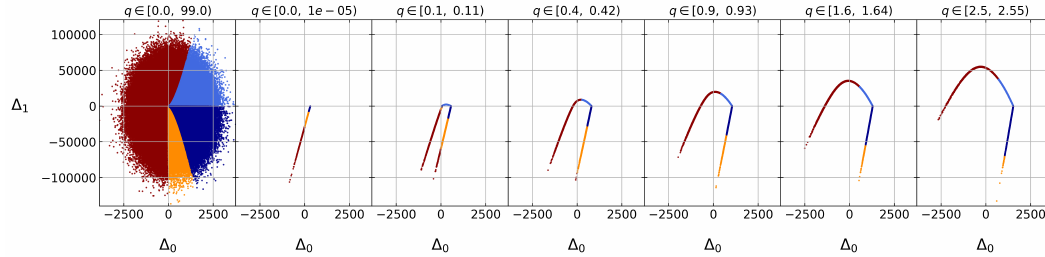
) -plane. Moving across: toys in , ∆ 0 1 . c true